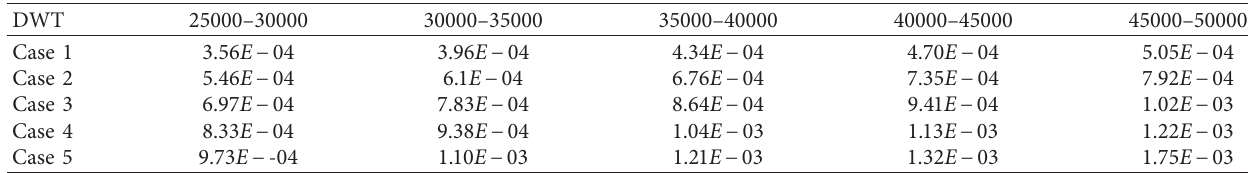
Table 7: Dynamic response of main tower (Rad).